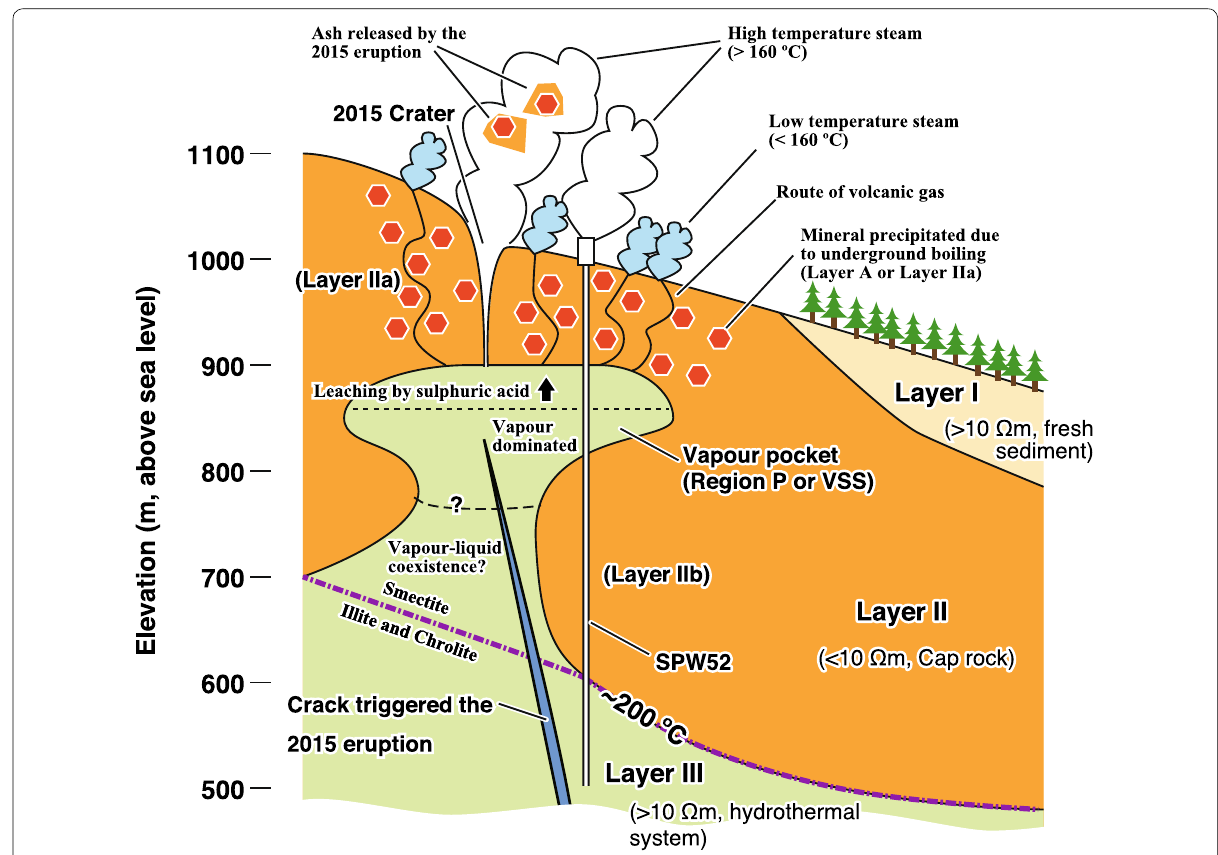
Fig. 9 Schematic geological model of 2015 eruption center and adjacent area. Beneath the eruption center area, a vapor pocket is formed, and the steam migrates from the pocket to the surface through Layer IIa, which is a sub-unit of Layer II characterized by mineral formation due to boiling. Mineral assemblage from the borehole data indicates an underground temperature of approximately 200 °C, even at the bottom of SPW52. The open crack formed at 7:32 on June 29, 2015 (JST), triggered the eruption; however, the uppermost tip did not reach the surface. The steam emitted by the eruption originated from the vapor pocket, and craters were formed by the erosion of Layer A or Layer